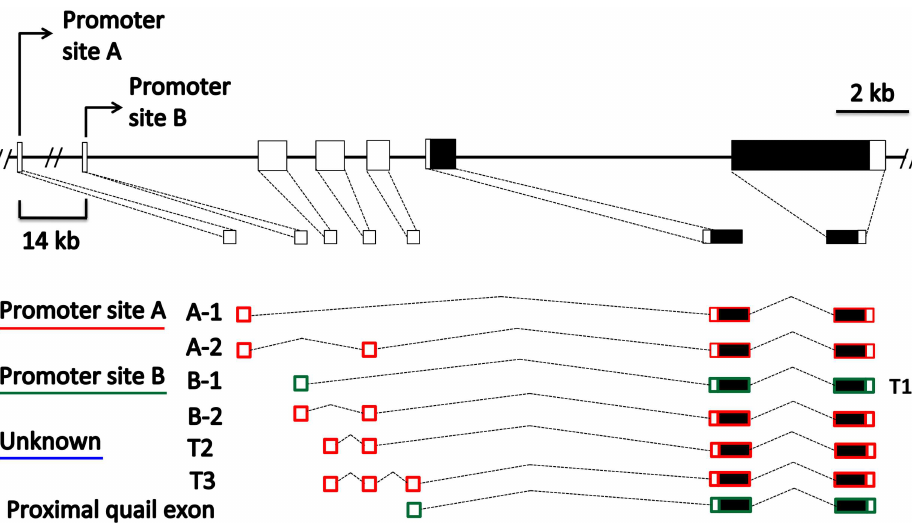
Fig 5. Correspondence between alternatively spliced transcripts of POMC in embryonic and adult Japanese quail, and chicken. Chickenpromoter sites and alternatively splicedtranscripts are listed on the left, and the corresponding quail transcript is listed to the right of the transcript. Quail POMC transcripts that have no correspondence with chicken transcripts are listed with the novel promotersite [5]. Empty boxes representnon-codingexons and solid boxes denote codingexons. The previously describednon-coding exons that were amplifiedin quail embryonic development are representedwith green, whereasred denotes the combination of promoter site and non-codingexons that we were unableto amplify. The promoter sites for T2, T3 and the proximalquail exon are unknown.